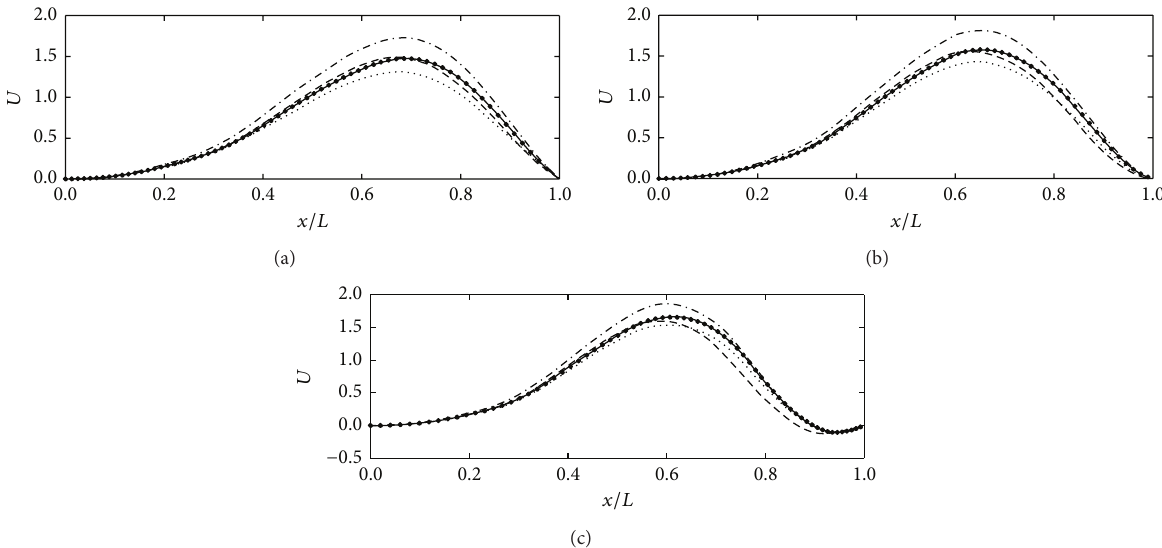
Figure 11: Normalized Displacement under the equivalent moving loads with the initial speed given by 𝜏 = 0.5 . 𝛽 = 0.03 . (a) 𝜆 = 1 , (b) 𝜆 = 0 , and (c) 𝜆 = −1 . Solid line: without neglected; dashed line: with inertia force neglected; dotted dashed line: with Coriolis force neglected; dotted line: with centrifugal force neglected; bold dotted line: with tangential force